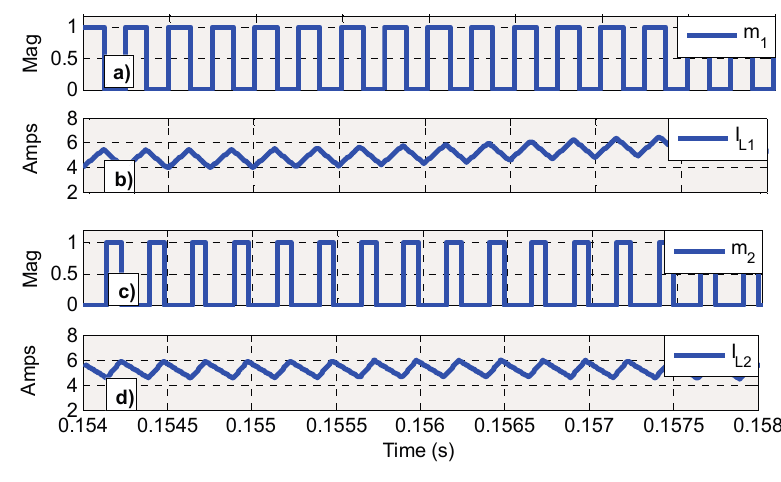
Figure 8. I L 1 and I L 2 currents for buck converters.